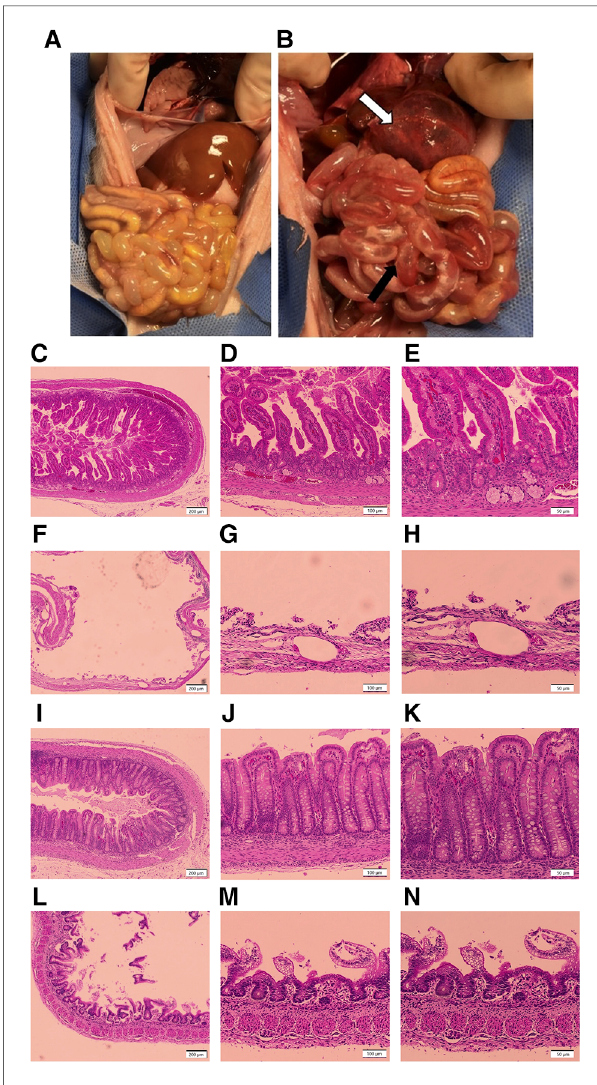
FIGURE 1 Representative gross and histologic intestinal images. ( A,B ) Gross Injury. ( A ) Image from a healthy piglet from the colostrum-fed group with no intestinal injury, corresponding to a gross injury score of 1; ( B ) image from a piglet in the formula-fed group, with extensive hemorrhage of the stomach (white arrow), and hyperemia and edema with focal areas of pneumatosis intestinalis in the mid small bowel (black arrow), corresponding to a gross injury score of a 5. ( C – N ) Histologic Injury. ( C – E ) Image of healthy small intestine from a piglet in the colostrum- fed group with no evidence of damage, corresponding to a histologic injury score of 1 at ( C ) 4×, ( D ) 10×, and ( E ) 20× magni fi cation; ( F – H ) image of small intestine from a piglet in the formula-fed group demonstrating transmural necrosis, scant villi, and widespread pneumatosis, corresponding to a histologic injury score of 5 at ( F ) 4×, ( G ) 10×, and ( H ) 20× magni fi cation; ( I – K ) image of healthy colon from a piglet in the colostrum-fed group with no evidence of damage, corresponding to a histologic injury score of 1 at ( I ) 4×, ( J ) 10×, and ( K ) 20× magni fi cation; ( L – N ) image of colon from a piglet in the formula-fed group demonstrating mucosal sloughing with red blood cell in fi ltration, corresponding to a histologic injury score of 4 at ( L ) 4×, ( M ) 10×, and ( N ) 20× magni fi cation.